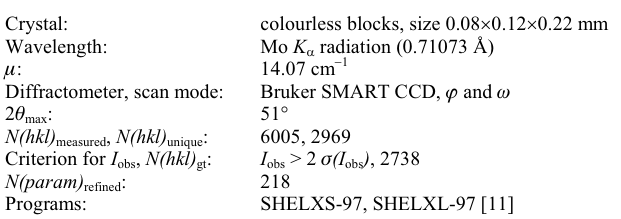
Table 1. Data collection and